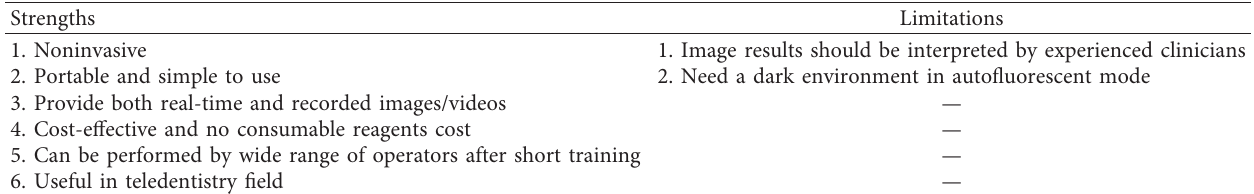
Table 5: Characteristics of the intraoral camera with fluorescent aids for the screening of OPMDs.